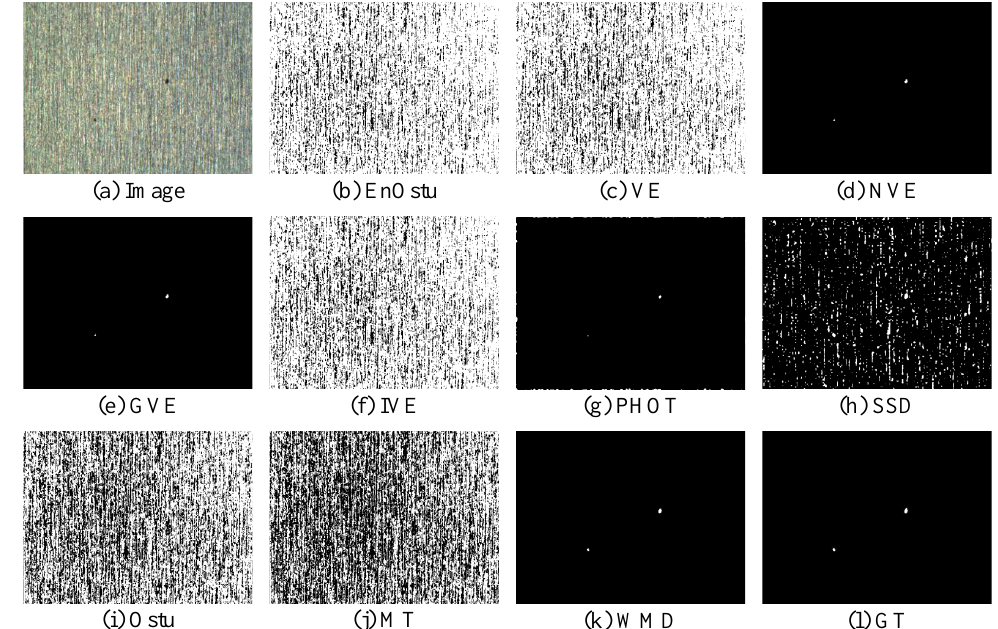
Figure 8. Visual comparisons of detection results of the ten methods on the image with multiple defects. The detection result of the proposed WMD method is quite close to ground truth, whereas the other competing methods are unable to either identify the defect location or completely separate the defect from the